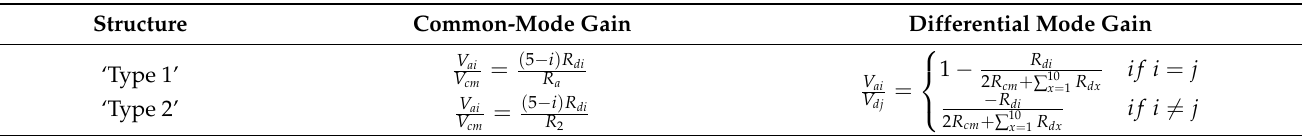
Table 5. Common-mode and differential gain for mismatched electrode impedances ( R d s are not equal but R a s, R cm s are equal).